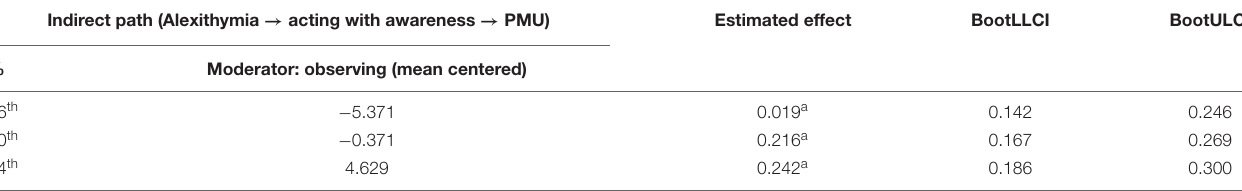
TABLE 5 | Bootstrapping the conditional indirect effect and 95% confidence interval (CI) for the moderated mediation model. Indirect path (Alexithymia → acting with awareness →